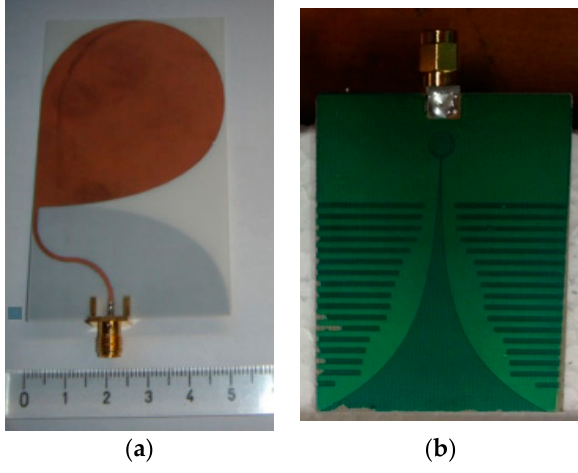
Figure 4. MWT antennas: ( a ) half-heart shape; ( b ) Vivaldi shape.